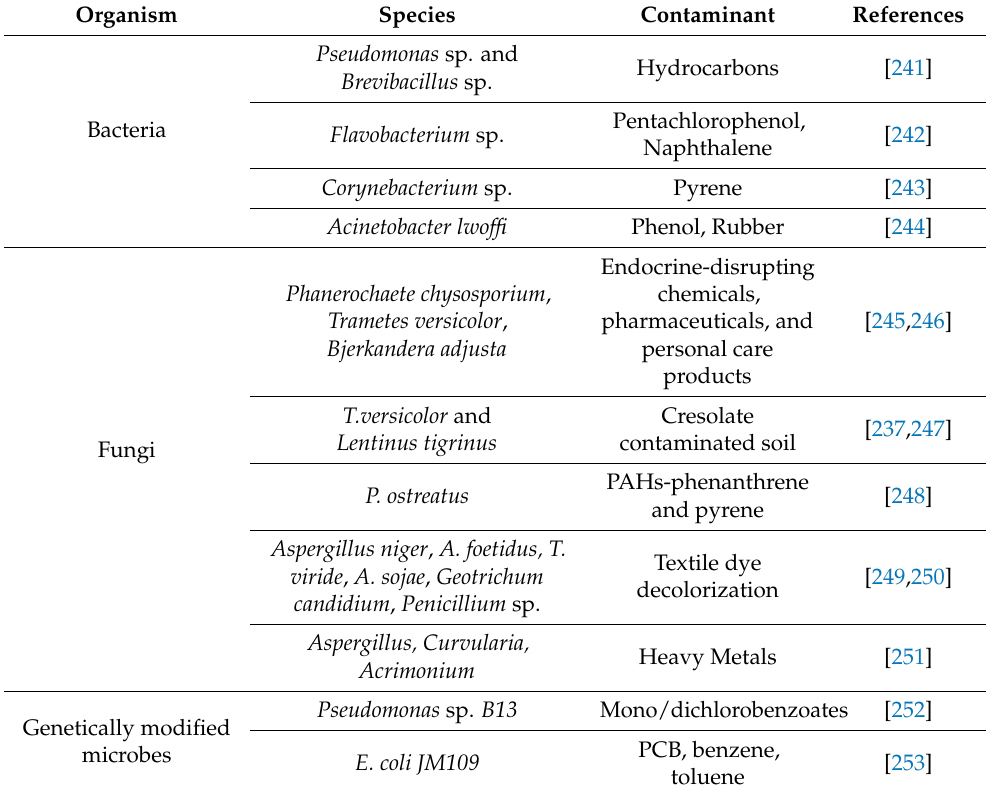
Table 3. Microbial organisms used for the bioremediation process of various mixed